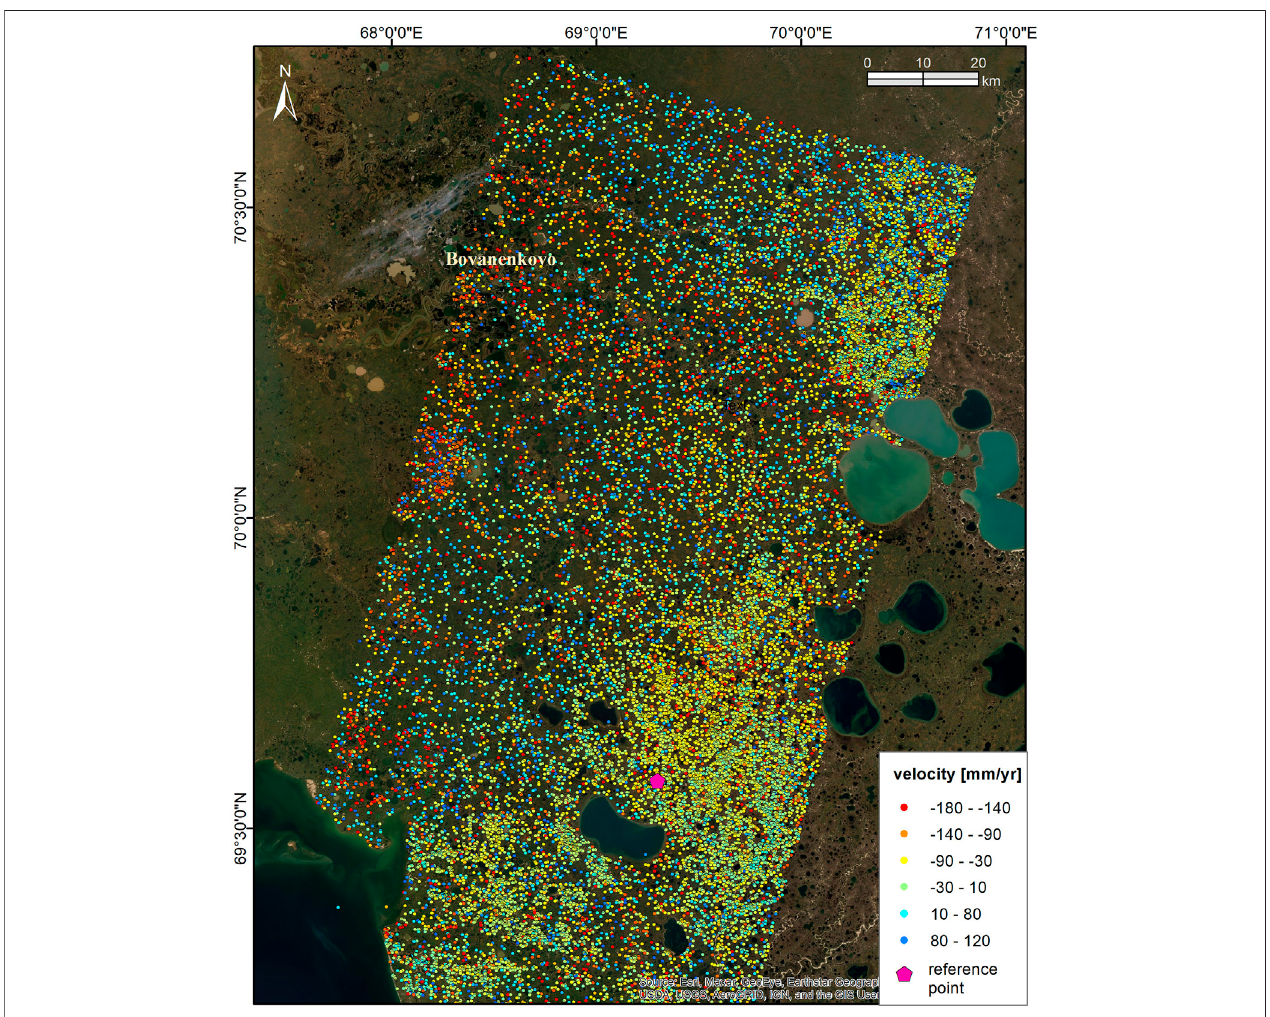
FIGURE 3 | Results of time-series InSAR analysis, colors show spatial pattern of seasonal subsidence velocity for June-October 2017 – 2018.